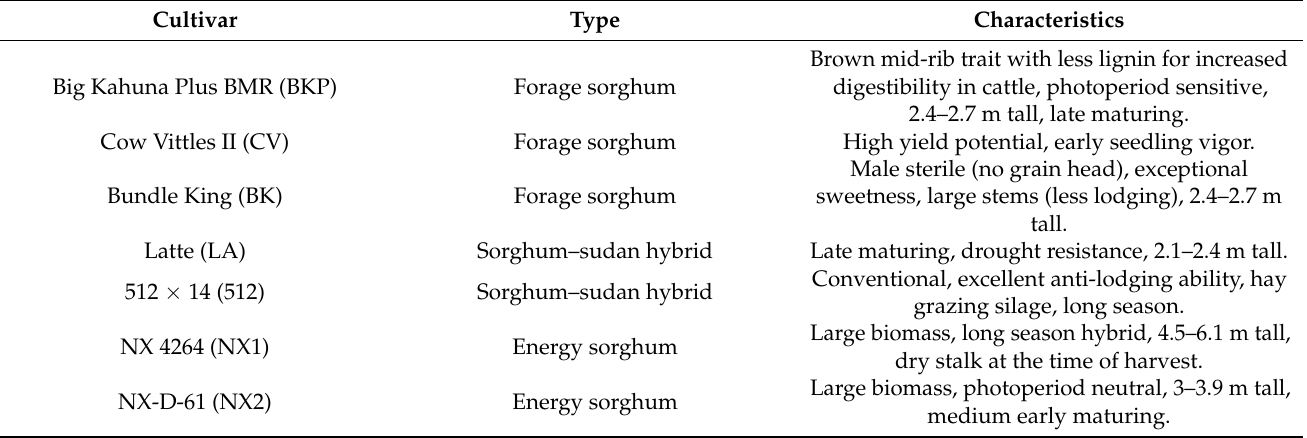
Table 1. SSgH varieties and their characteristic